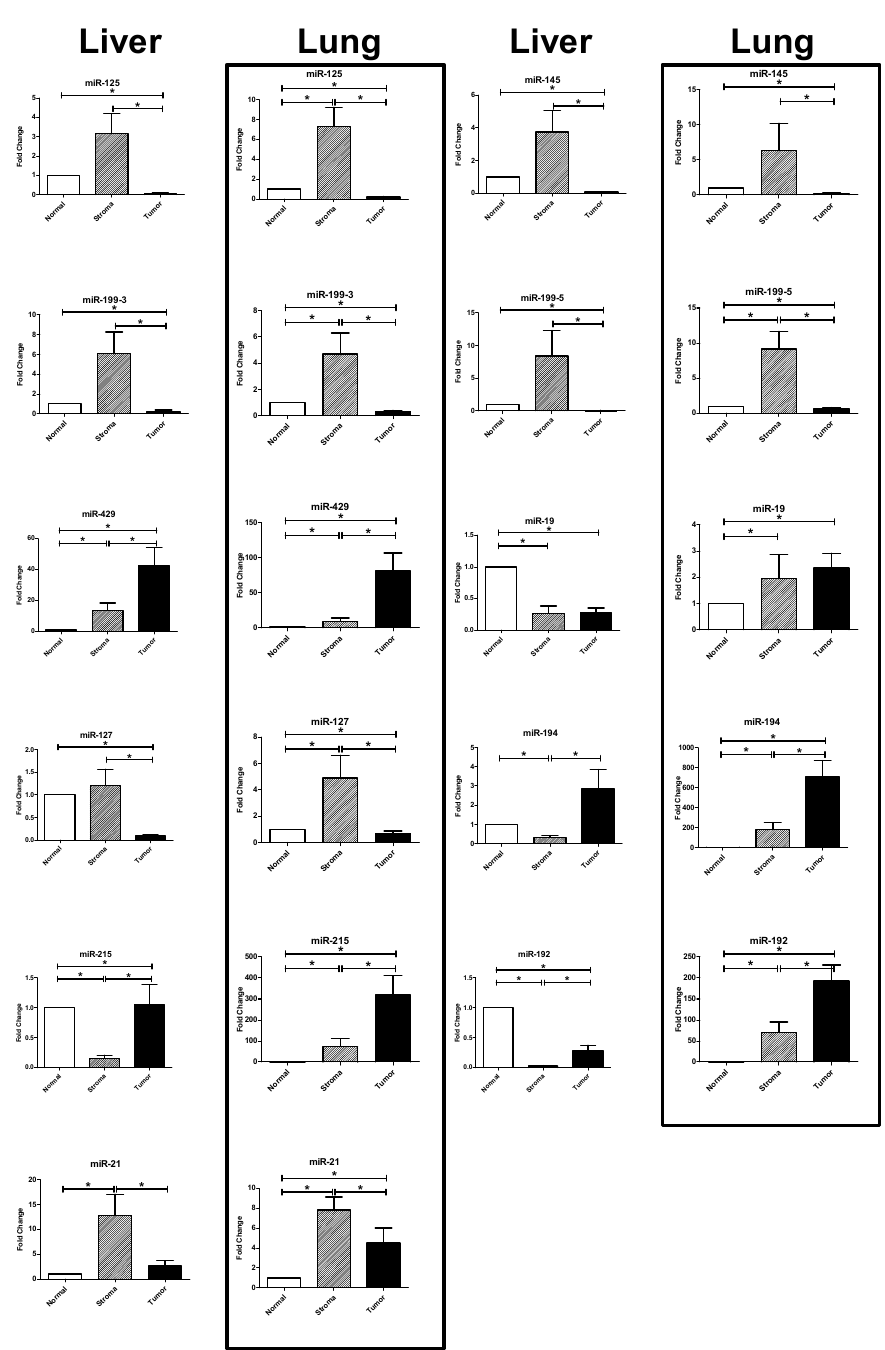
Figure 1. Differential expression between the tumoral, stromal, and host tissue compartment. The graphs show the mean expression difference and the standard error of the difference (SED) as a fold change ( ΔΔ C t -Method) compared to the expression in the normal tissue. p -Values were calculated using the t -test. Significant expression differences are marked with asterisks (*).